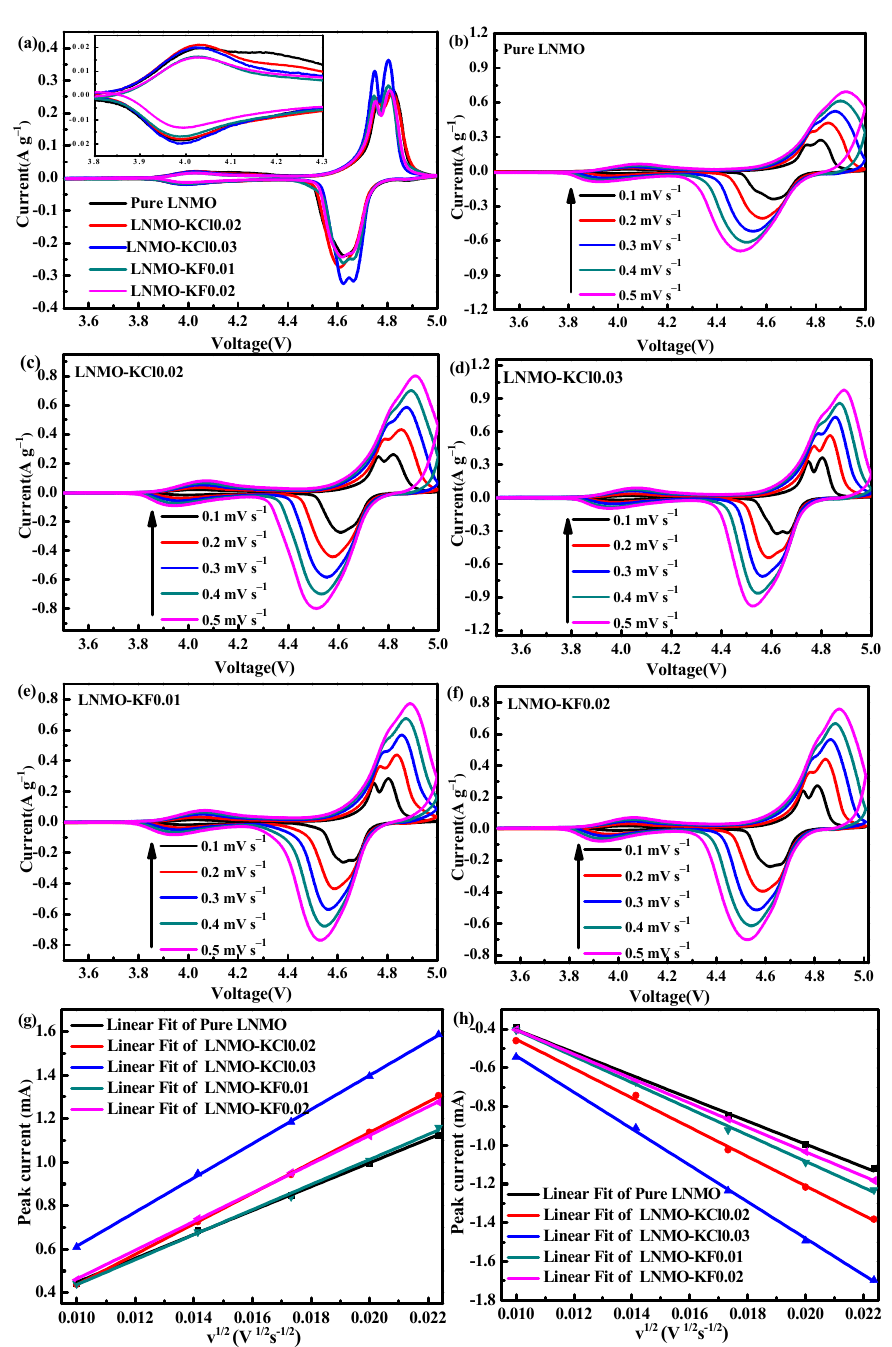
Figure 7. Cyclic voltammetry curves for all samples at 0.1 mV s − 1 ( a ) and for samples individually at scan rates from 0.1 mV s − 1 to 0.5 mV s − 1 ( b – f ); Plots of the peak current ( i p ) vs. the square root of the scan rate ( v 1/2 ) ( g , h ). Table 3. The diffusion coefficients of Li + in all samples.